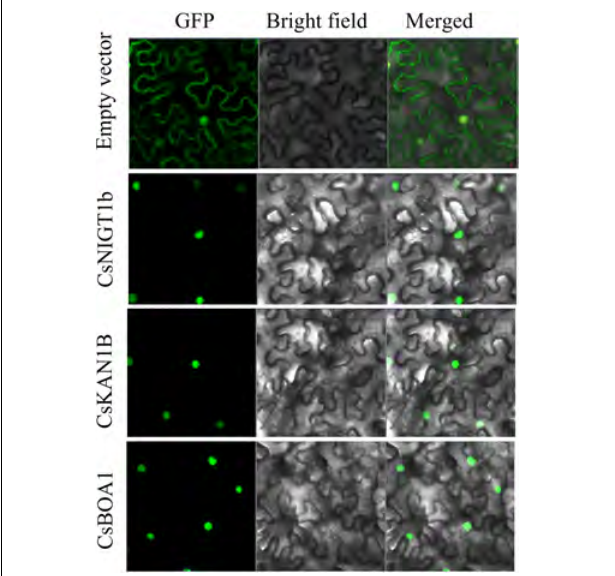
FIGURE 1 | Subcellular localization of CsNIGT1b, CsKAN1b, and CsBOA1 proteins. The free GFP and recombinant GFP proteins of CsNIGT1b, CsKAN1b, and CsBOA1 were transiently expressed in tobacco leaves and observed using a fluorescence confocal